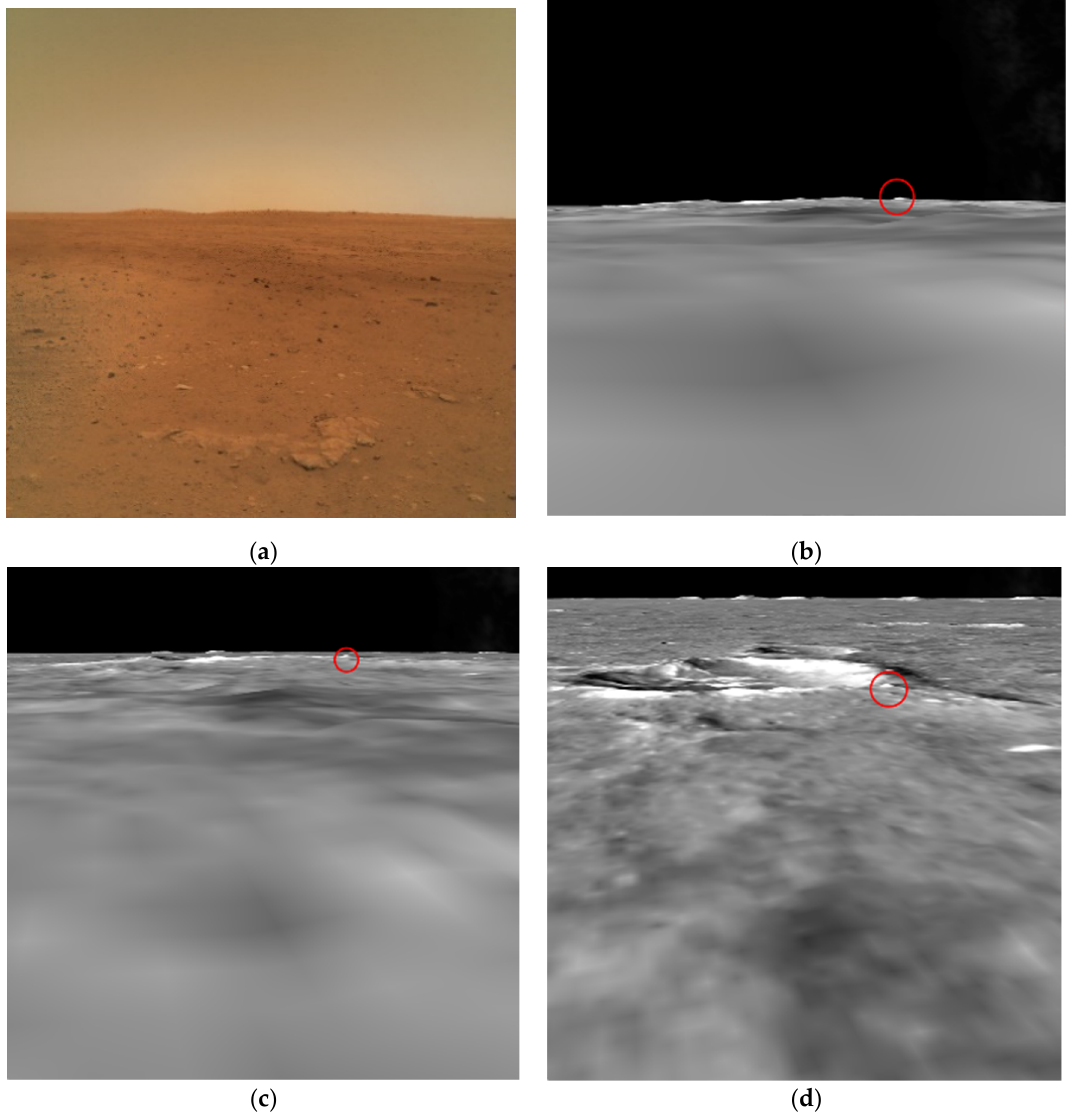
Figure 4. The original and simulated NaTeCam images: ( a ) is the original NaTeCam image received on 22 May, 14:00 (UTC +8); ( b ) is the simulated image generated from the same azimuth and altitude angle as ( a ) based on the orbital DEM and DOM; ( c ) and ( d ) are the simulated images at incremental heights based on the orbital DEM and DOM. The red circle is a landmark on the Martian surface.